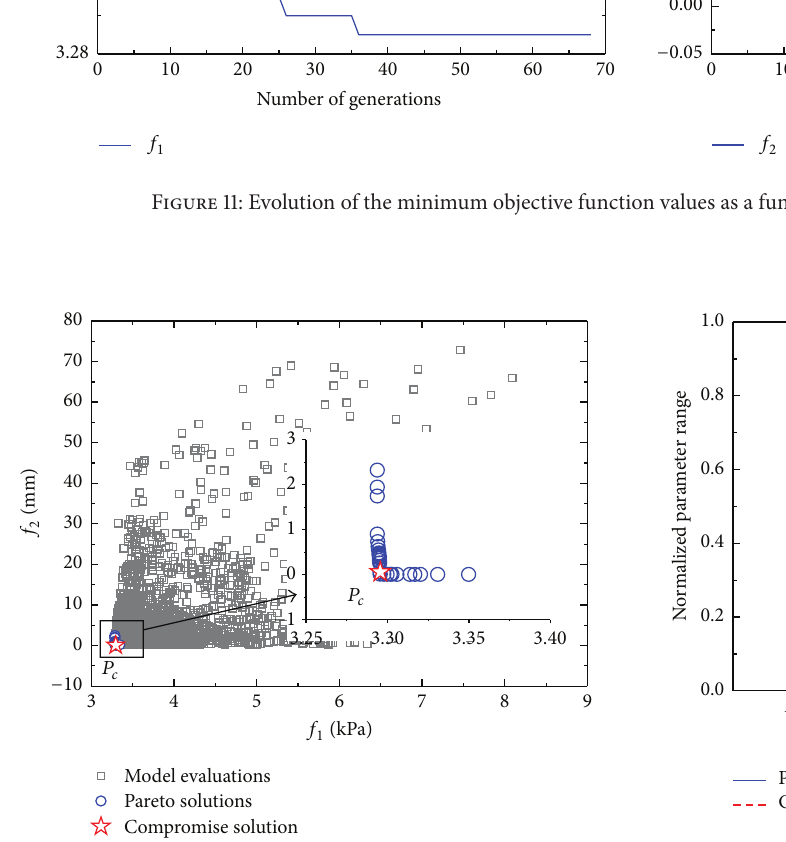
Figure 12: Pareto front and optimal solutions.